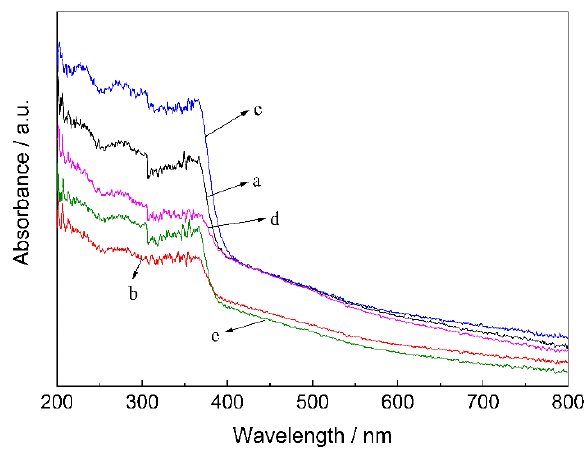
Figure 3. UV–vis absorbance spectra of different samples.